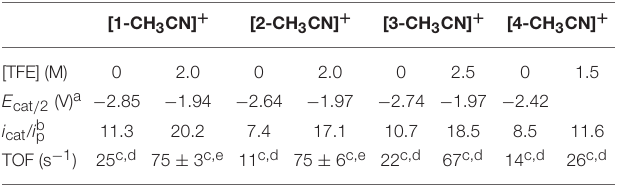
TABLE 3 | Summary of electrocatalysis data derived from voltammetry experiments, in the absence of TFE and at optimum TFE concentrations. [1-CH 3 CN] +